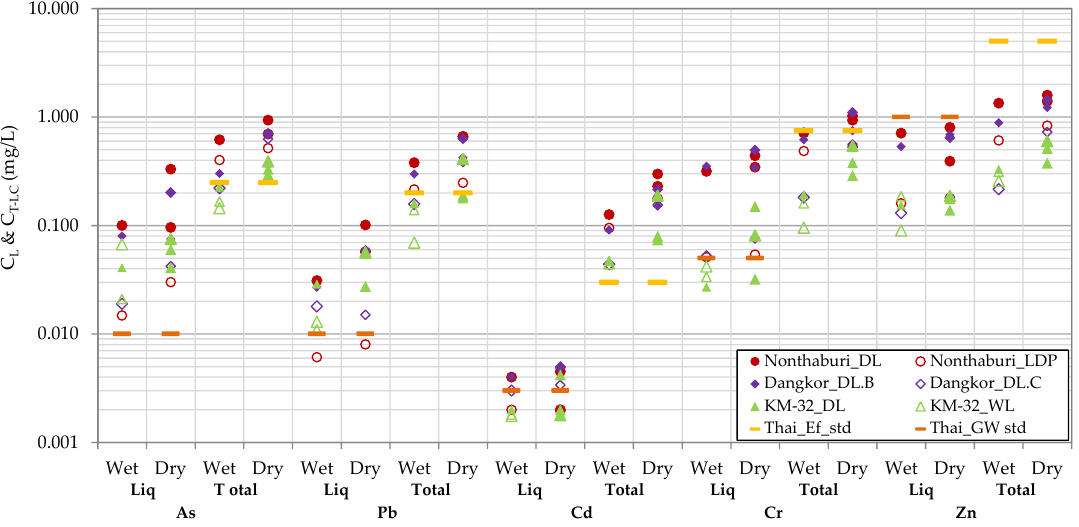
Figure 8. Heavy metal concentrations of the total ( Total ) and liquid part ( Liq ) of the leachate.